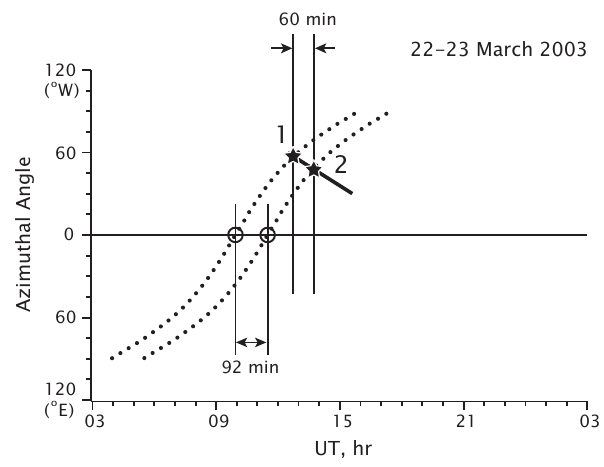
Fig. 8. Graphical estimation of zonal drift velocity (see the text for